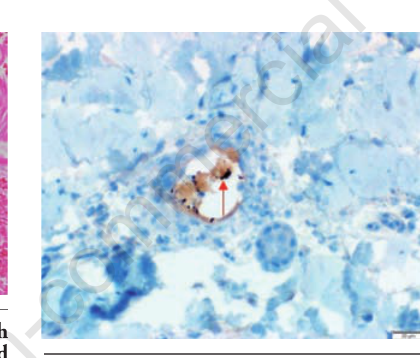
Figure 7. MRSA antibody stain demon- strating bacteria in soft tissue.